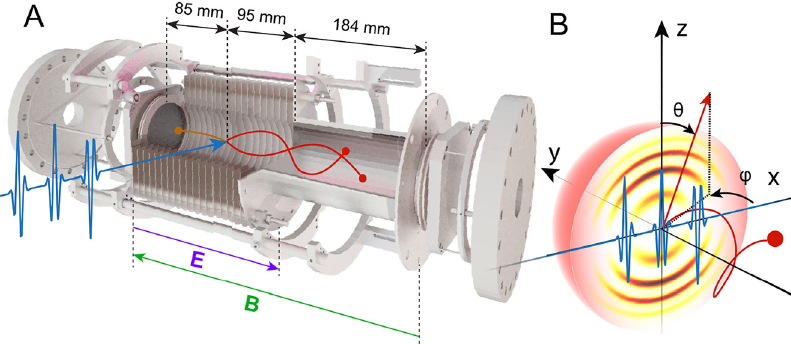
Figure6: 3DPhotoelectron/ionspectrometer (CIEL). (A) Working principle of the CIEL. (B) Coordinate systemused for measurements, along with a 3D representation of the electronmomentumdistribution,indicating the azimutal angle ( φ ) and elevation angle ( θ ) with respect to the plane of the laser polarization (along the